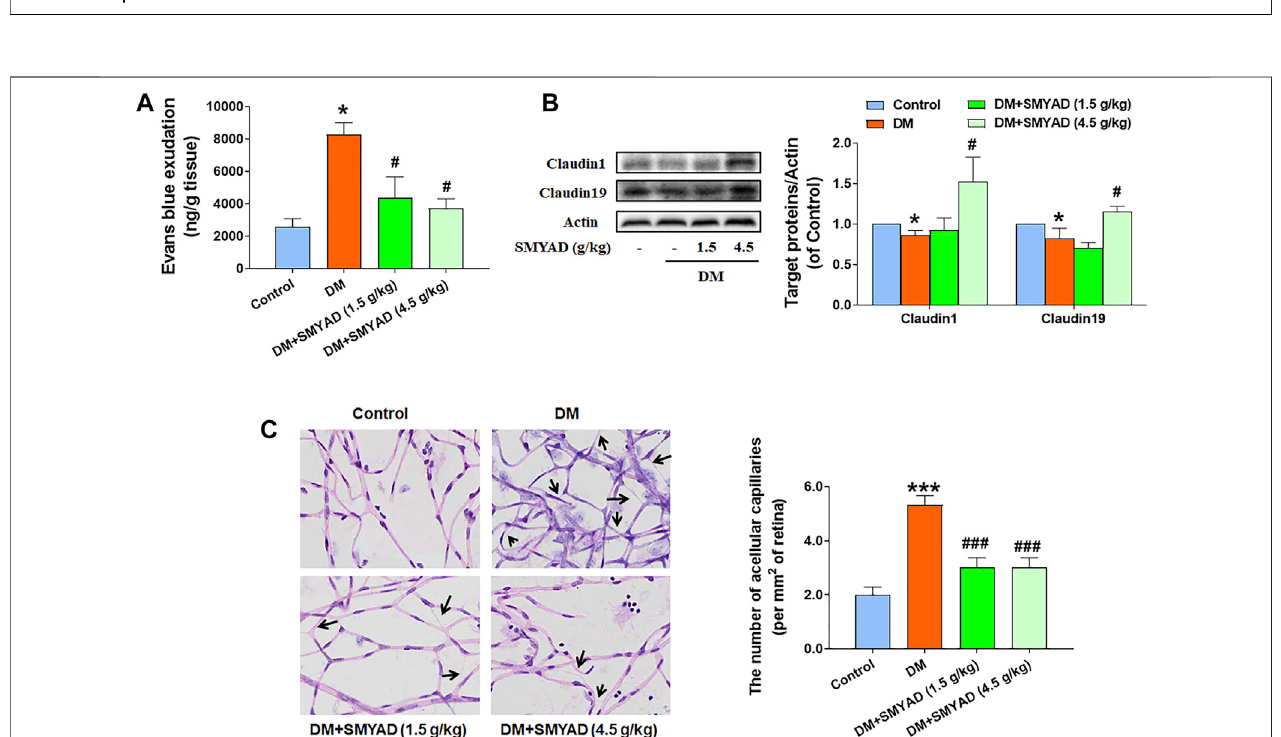
FIGURE 2 | SMYAD alleviated BRB dysfunction in vivo . (A) Evan ’ s blue leakage assay (n (cid:2) 4). (B) Claudin1 and claudin19 expression in retinas. The quantitative result is shown at right (n (cid:2) 3). (C) Retinal H and E staining. The number of acellular capillaries per fi eld in retinas is shown at right (n (cid:2) 3). Black arrows indicate acellular capillaries. Data (cid:2) mean ± SEM. * p < 0.05, *** p < 0.001 vs. control; # p < 0.05, ### p < 0.001 vs. DM.